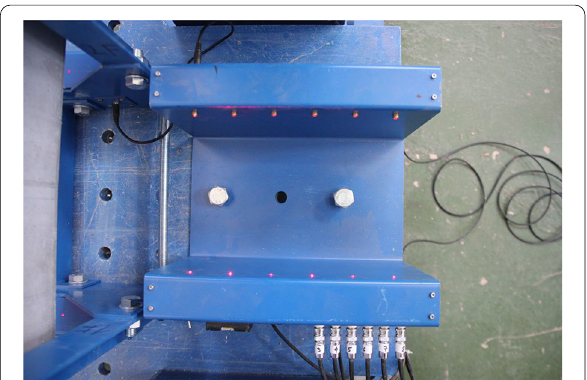
Fig. 5 The smaller optical gate device for tracking the impactor.